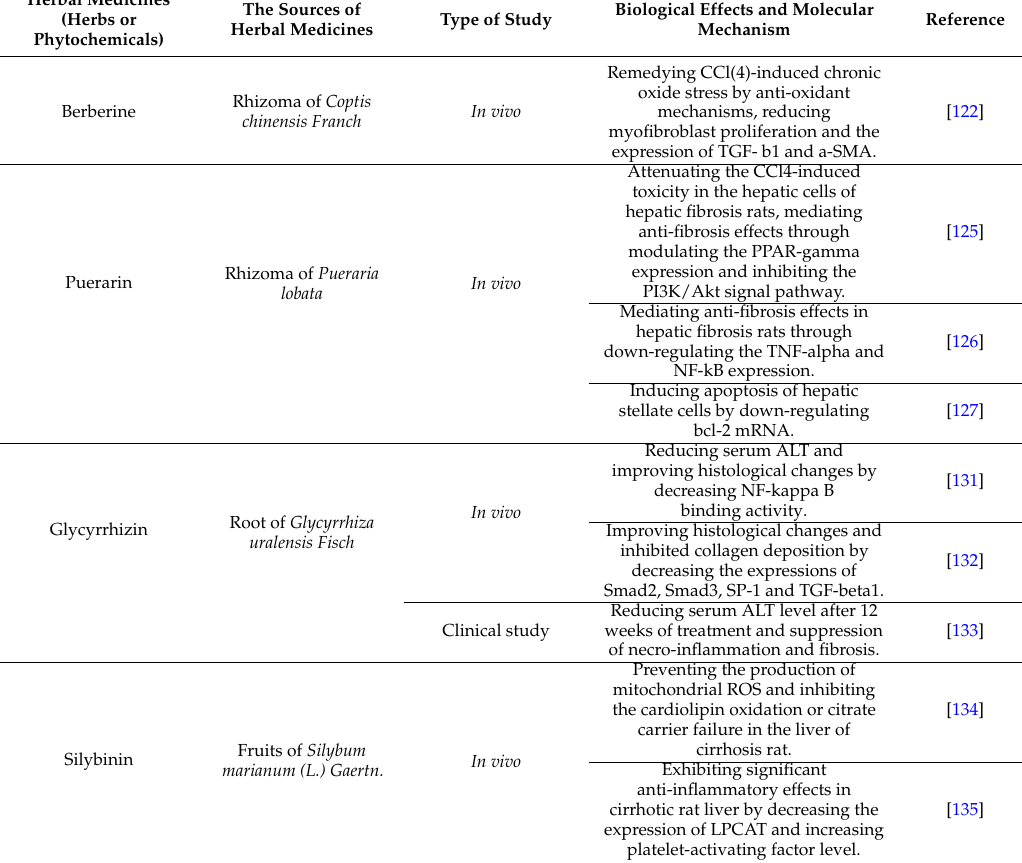
Table 3. Herbs and phytochemicals in cirrhosis